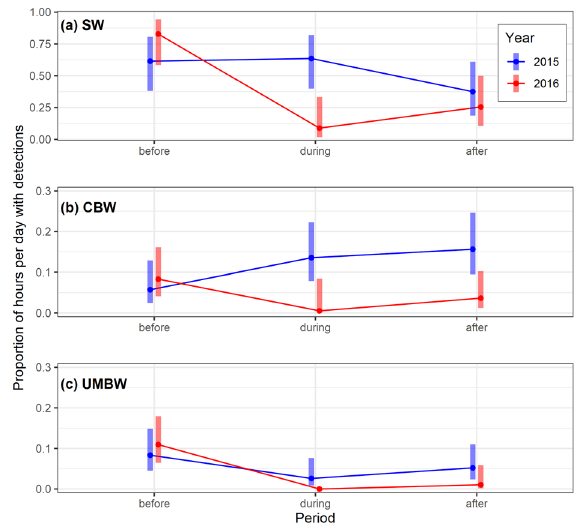
Figure 6. Interaction plots of the estimated marginal means and 95% confidence intervals from fitted GLM models testing the effects of period and year on the mean proportion of hours per day with echolocation clicks